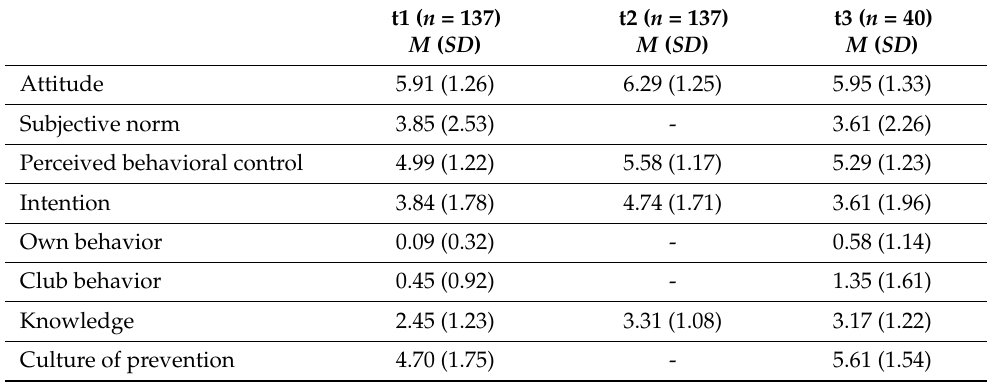
Table 2. Means and standard deviations for all constructs measured at all points of measurement for the whole